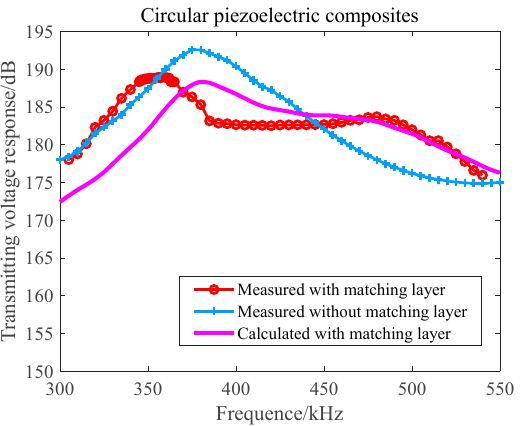
Figure 13. Transmitting Voltage Response–Frequency Curve of the Circular Transmitting Array.